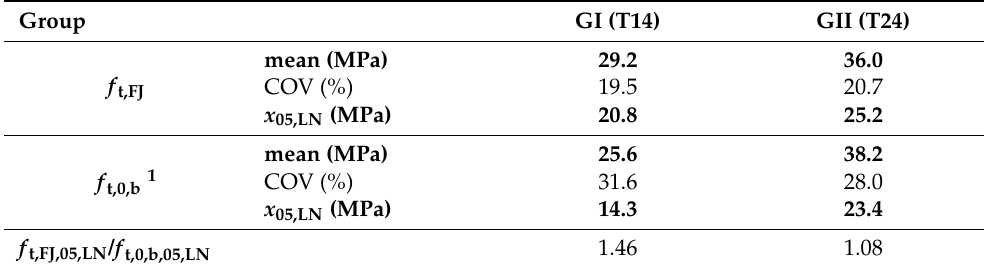
Table 10. Main statistics of the tensile strength parallel to the grain ( f t,FJ ) of 1.5 × 10 4 simulated finger joints and of the tensile strength parallel to the grain ( f t,0,b ) of 1.5 × 10 4 simulated boards featuring w b = 150 mm and l b = 2